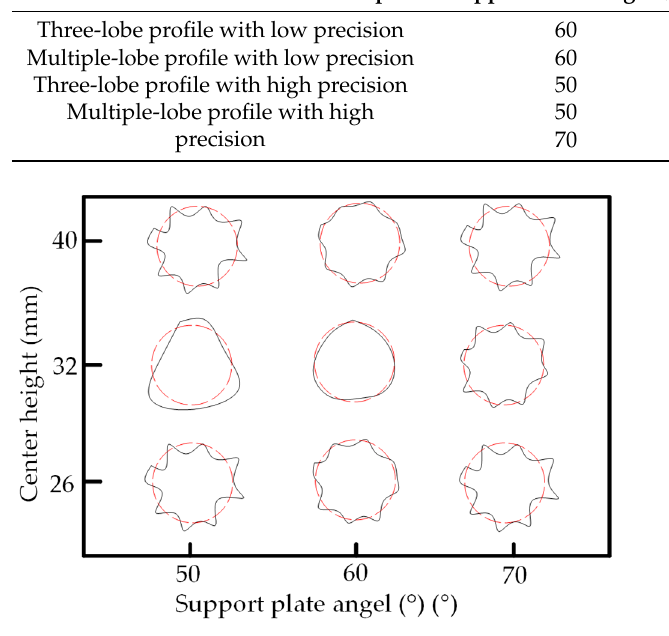
Figure 5. Profile shapes under different processing parameters.